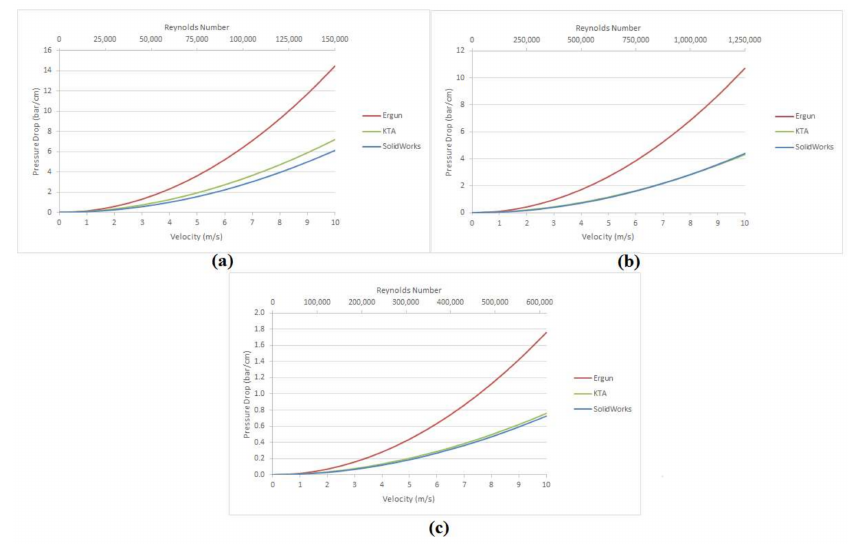
Figure 19. Pressure drop calculation method comparison for random packing of 15 mm spheres ( a ) 20 ◦ C; ( b ) 300 ◦ C; ( c ) 400 ◦ C.